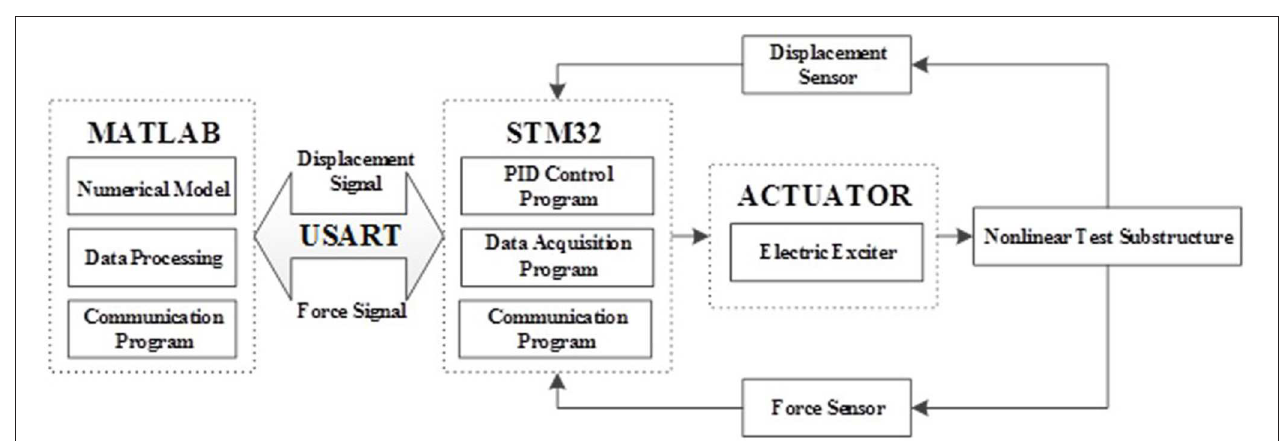
FIGURE 1 | The hybrid test system.